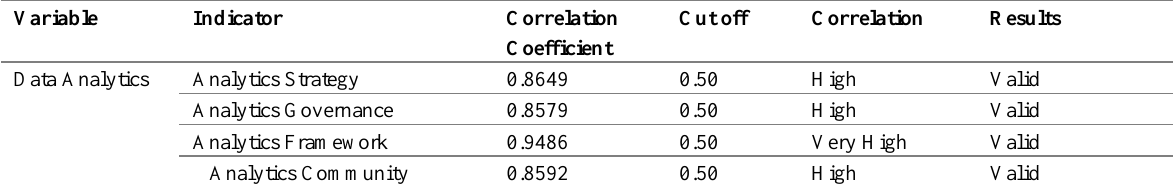
Table 2: Data Analytics Variable Validity Test